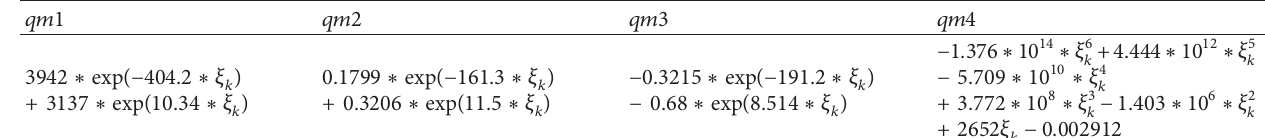
Table 11: Coefficients of (65).